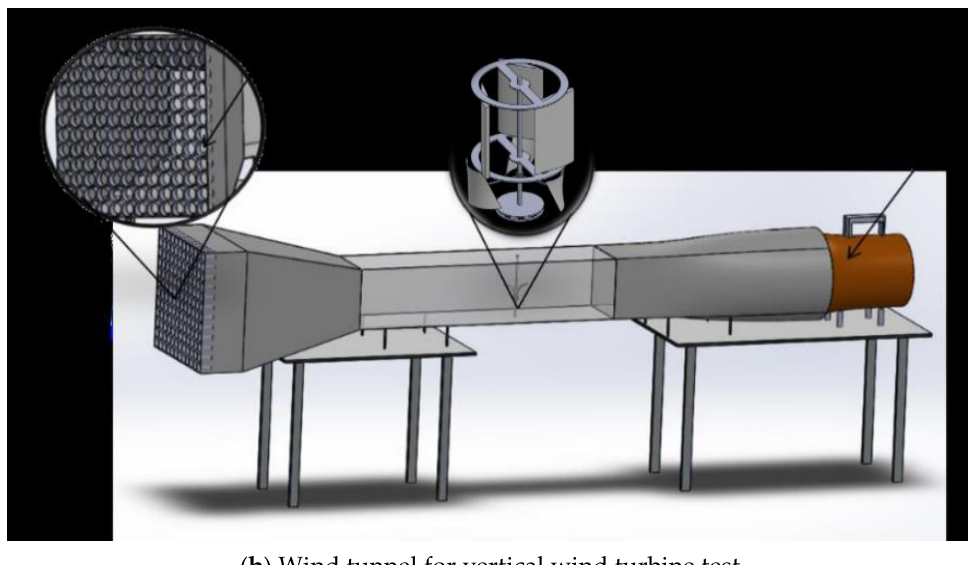
Figure 1. A vertical wind turbine blade section ( a ), and the wind tunnel test ( b ).